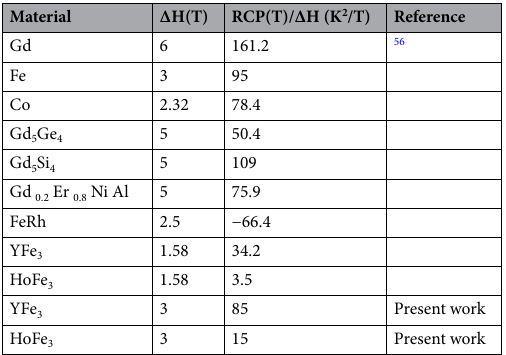
Table 3. The Relative Cooling Power RCP (T), using our calculation, in comparison to experimental data.